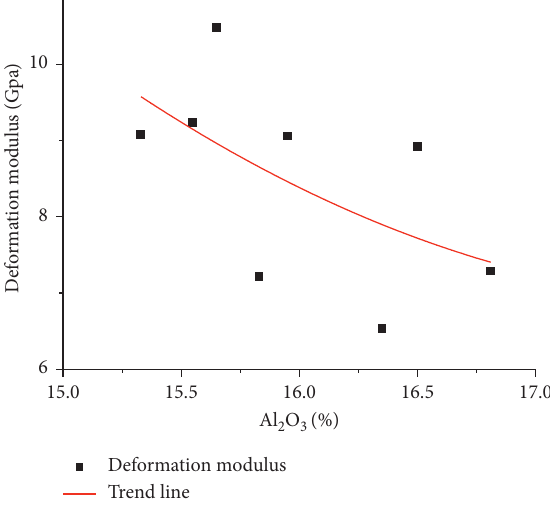
Figure 9: Relationship between mineral composition and deformation modulus of deep sandstone